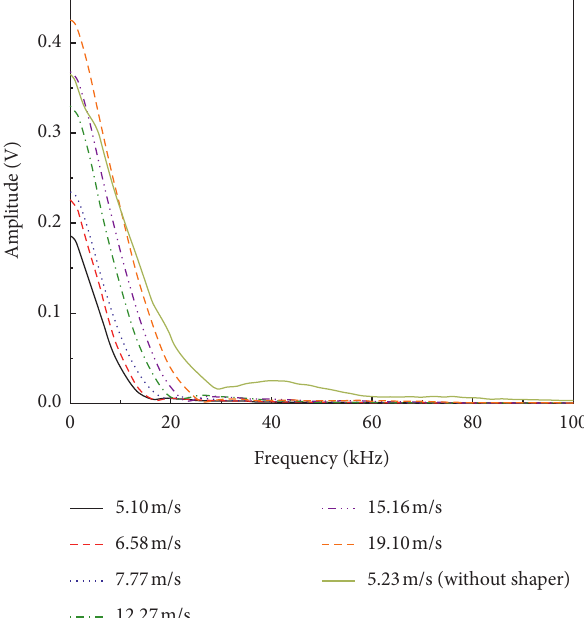
Figure 5: The amplitude-frequency relationships of incident wave at different impact